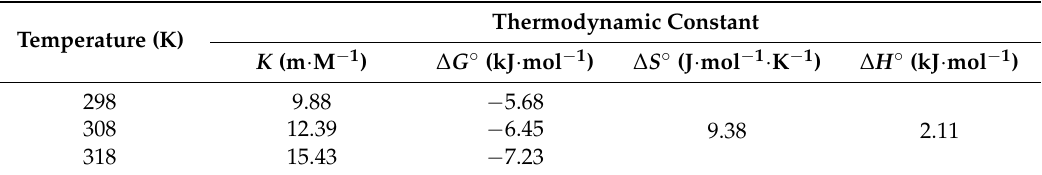
Table 2. Thermodynamic parameters for the adsorption of Sr on the composite magnetic nanoparticles.